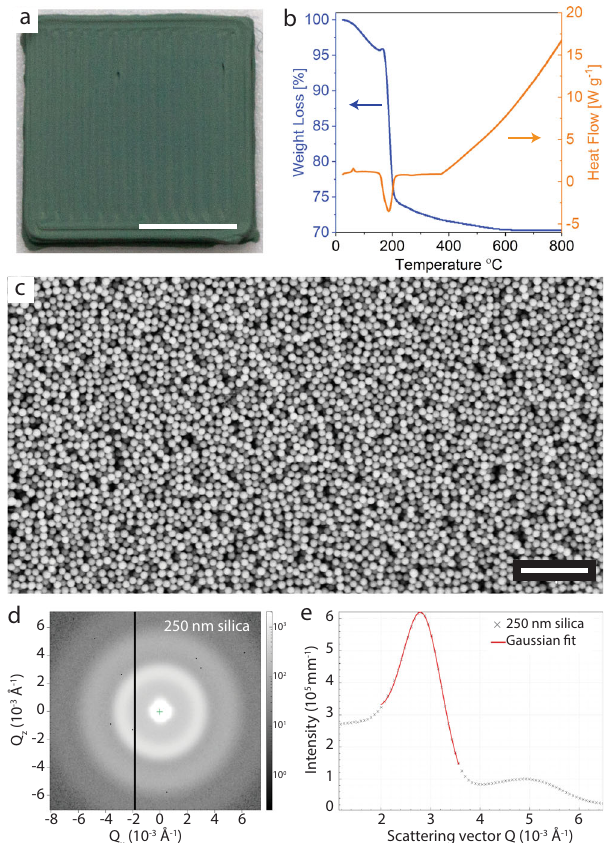
Fig. 3|Structureofprintedand heat-treatedphotoniccolloidalglass. a Picture of a printed object after heat treating at 200°C. b Thermal gravimetric analysis (TGA) and differential thermal analysis (DTA) of an as-printed object subjected to heating in air. c Scanning electron microscopy (SEM) image, d SAXS pattern, and e azimuthal X-Ray intensity as a function of scattering vector ( Q ) obtained for a printedcolloidalglassafterheattreatingat200°C.Allstructureswereprintedfrom a colloidal ink containing 250nm silica particles. Scale bar in a is 5mm and in c is 2 µ m. The vertical line in (d) is an instrumentation artifact due to the interface between detectors (see Supplementary Note 4 for details). Source data for b and e are provided as a Source Data fi